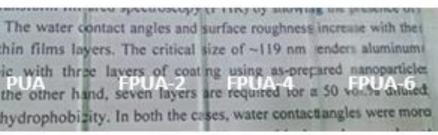
Figure 8. The visibility of the UV-LED curable coating at different fluorinated monomer content when placed on a piece of paper.